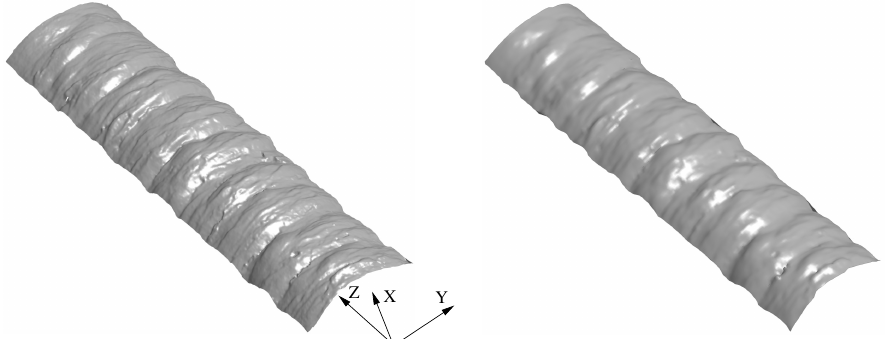
Figure 10. Reconstruction of rough surface of a specimen using GiD: data generated with ( left ) 6 px point distance and 9 px for facet size, ( right ) 15 px point distance and 19 px for facet